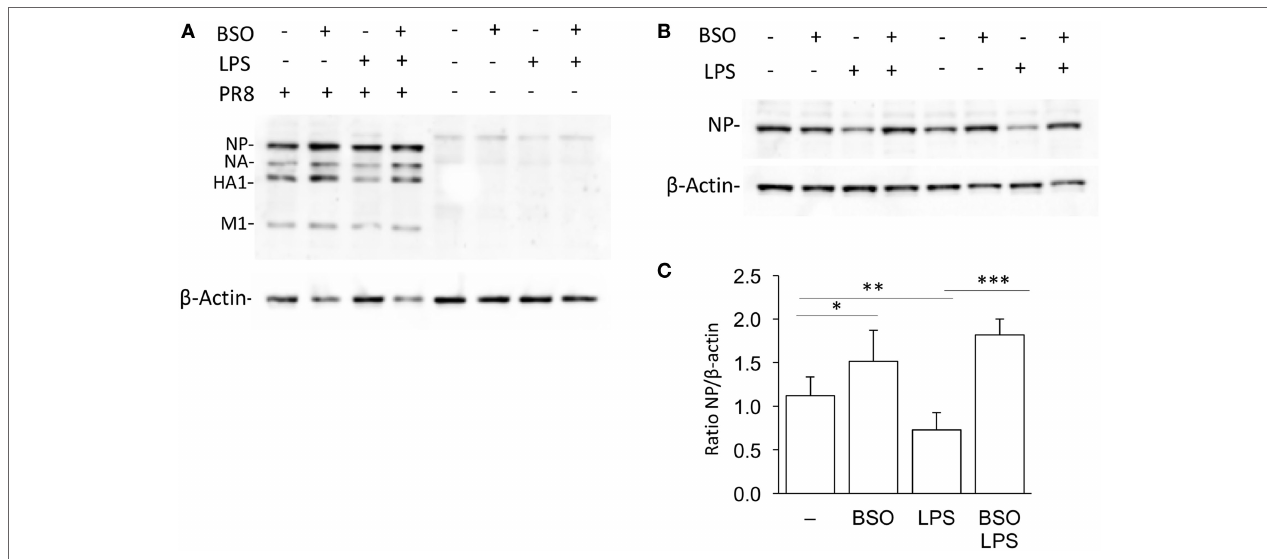
FigUre 8 | LPS activation of antiviral innate immunity is dependent on GSH. (a) Western blot for influenza virus proteins in RAW cells infected with PR8 or uninfected, after LPS treatment, with and without GSH depletion. β -Actin was used as loading control. Representative of two Western blots ( N = 2 biological replicates). (B) Levels of NP viral protein in RAW cells pretreated with LPS, with and without GSH depletion. Representative of four Western blots ( N = 8 biological replicates from two independent experiments). (c) Densitometric analysis expressed as the mean ± SD of the ratio NP/ β -Actin from eight biological replicates from two independent experiments for a total of four Western blots. * P < 0.05, ** P < 0.01, and *** P < 0.001 by two-tailed Student’s t -test. GSH, glutathione; LPS, lipopolysaccharide; NP,